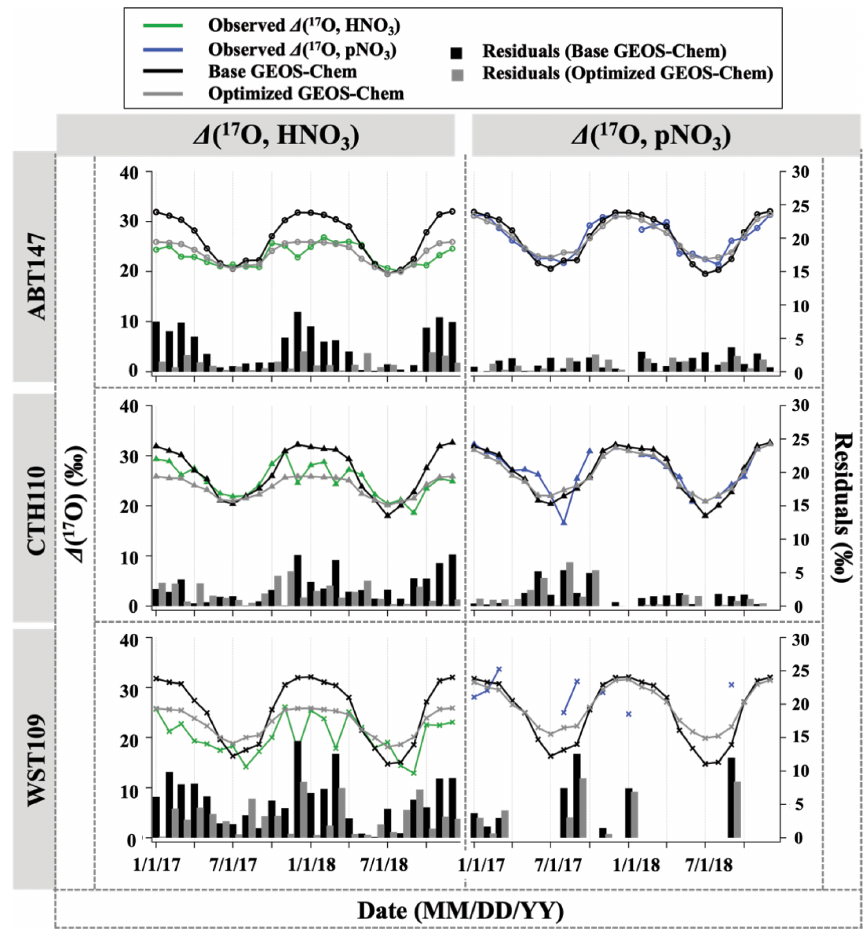
Figure 4. Time series of the monthly mean for observed and calculated (cid:49) ( 17 O) for HNO 3 and pNO 3 over ABT147, CTH110, and WST109 CASTNET sites. Calculated (cid:49) ( 17 O) using base (black) and optimized (gray) GEOS-Chem are shown in the plot together. Bars indicate the residuals between calculation and